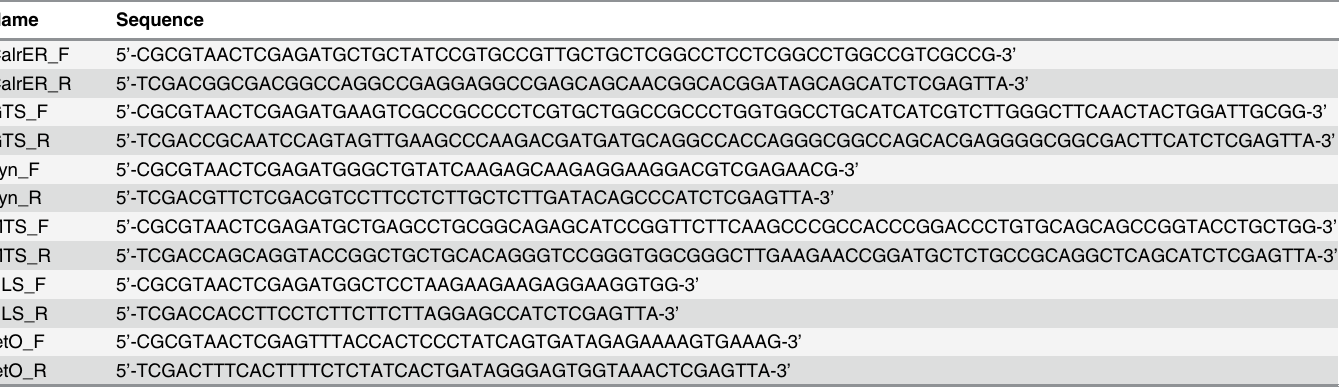
Table 4. Annealed pairs of oligos for direct